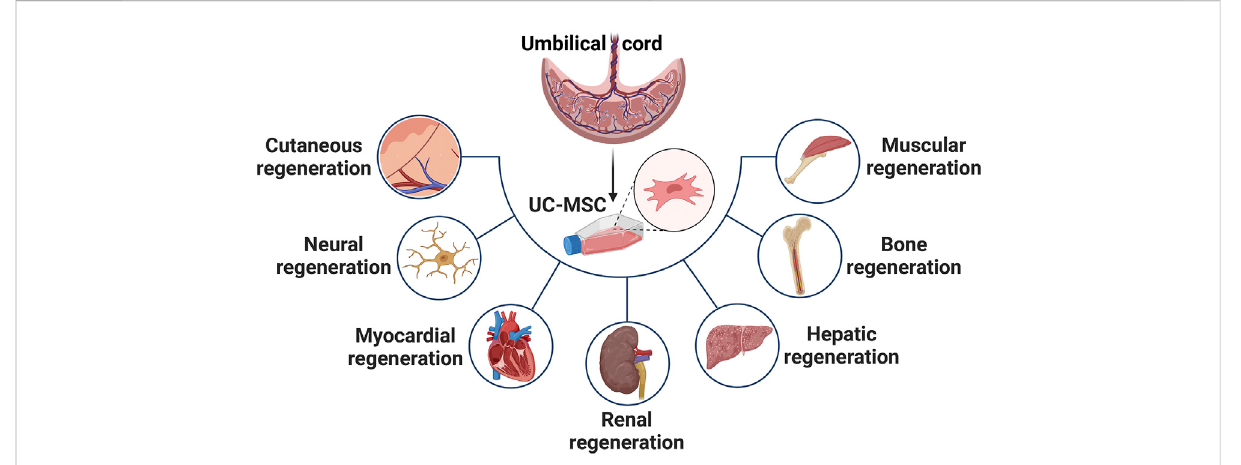
FIGURE 2 Highlights the applications of UC-MSCs for treatment of variety of diseases such as cutaneous, neural, myocardial, renal, hepatic, bone and muscular